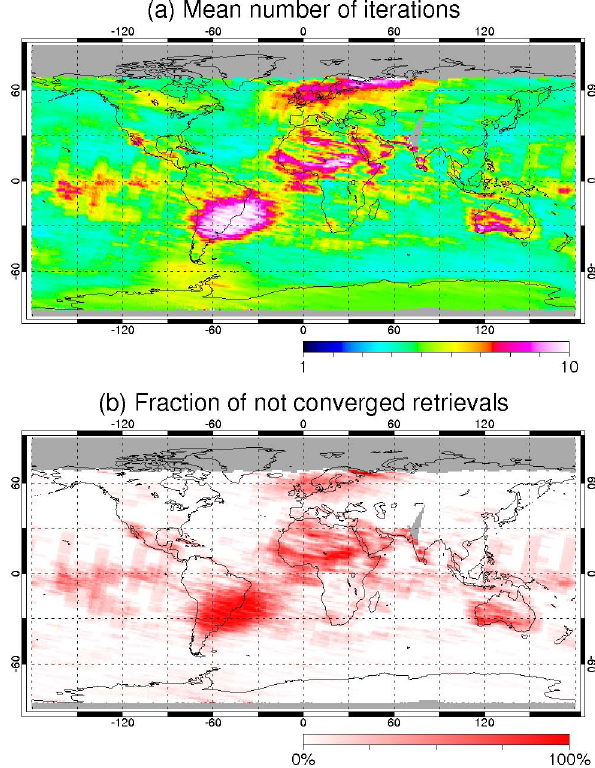
Fig. 2. (a) Mean number of iteration steps for all retrievals of Febru- ary 1998. Non-converging retrievals are broken off after 10 iteration steps. (b) Fraction of not converged retrievals. Note the distinct ar- eas of